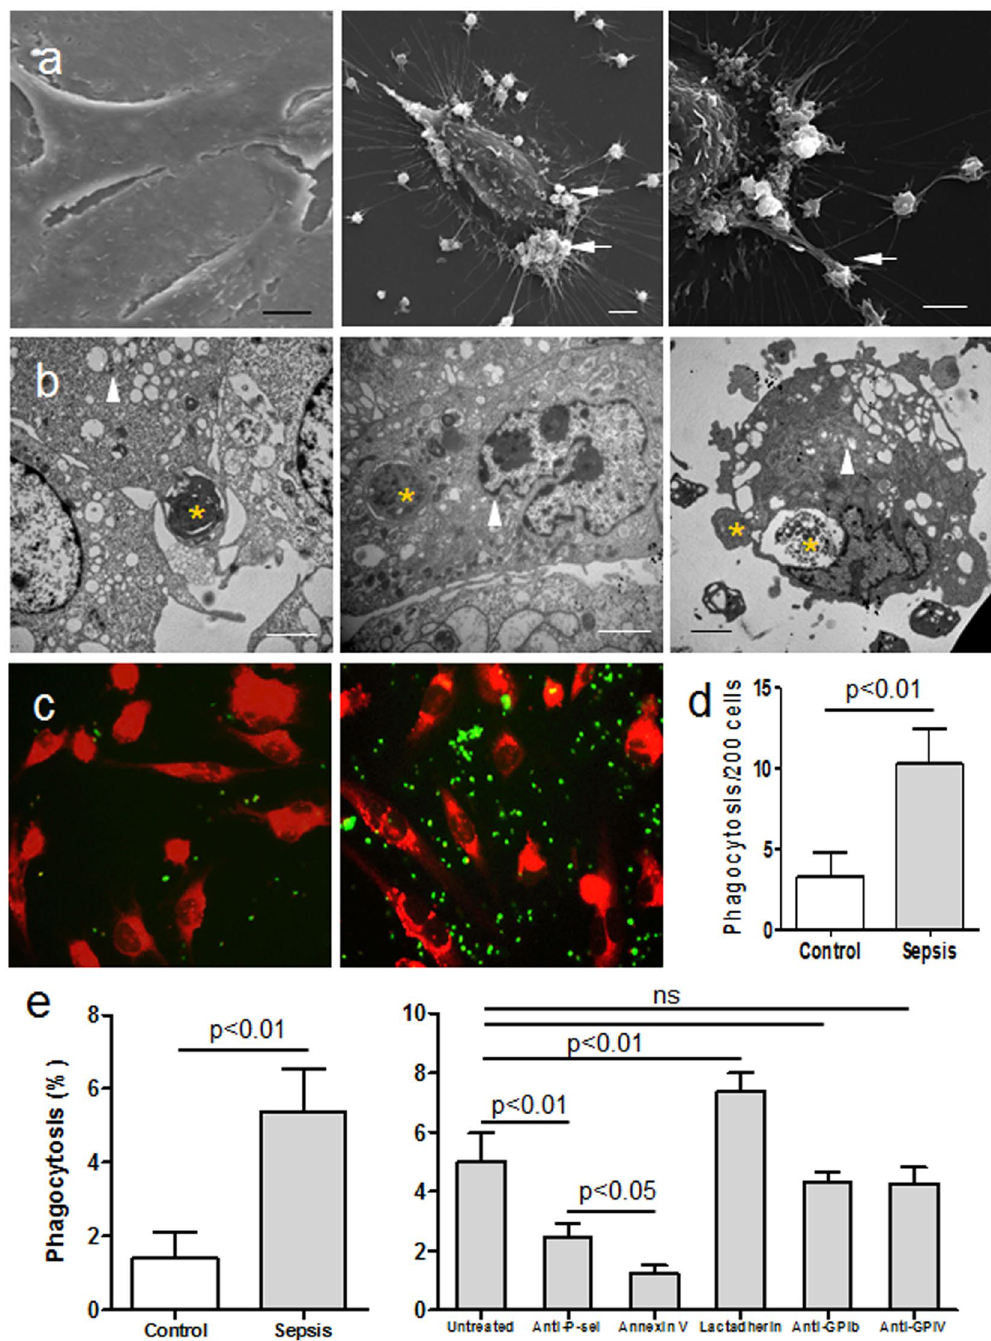
Figure 3. Phagocytosis of platelets by ECs in vitro . Platelets of healthy controls (n = 15) and patients (n = 15) were incubated with ECs (triangles) at 37 °C for 30 min and then the mixed cells were fixed for analysis ( a – e ). Scanning microscopy images showing that few platelets of healthy subjects adhered to ECs, and ECs did not extend pseudopodia ( a , left); ECs extended pseudopodia to grasp the stimulated platelets from patients ( a , middle and right), a proportion of which had anchored on ECs (arrows). ( b ) Transmission microscopy images showing several platelets from patients ( * ) being trapped, engulfed, and degraded in plasma by ECs. ( c ) CMTPX-labeled ECs (red) and CMFDA-stained platelets (green) from healthy controls (left) and patient samples (right) after co-culture for 30 min were observed using fluorescence microscopy to look for interactions between the two cell types. ( d ) The number of platelets engulfed by ECs (costained yellow) was counted under fluorescence microscopy. Data represents mean ± SD. ( e ) Percentage phagocytosis of platelets from healthy controls and patients were measured by flow cytometry (left). Alternatively, platelets from patients (right) were incubated with ECs in the presence of anti CD62P (20 µ g/ml), anti CD42b (20 µ g/ml), anti CD36 (20 µ g/ml), annexin V (2 nM), or lactadherin (2 nM). Data represents mean ± SD. Bars represent 2 μ m ( b ), 5 μ m ( a ) and 20 μ m ( c